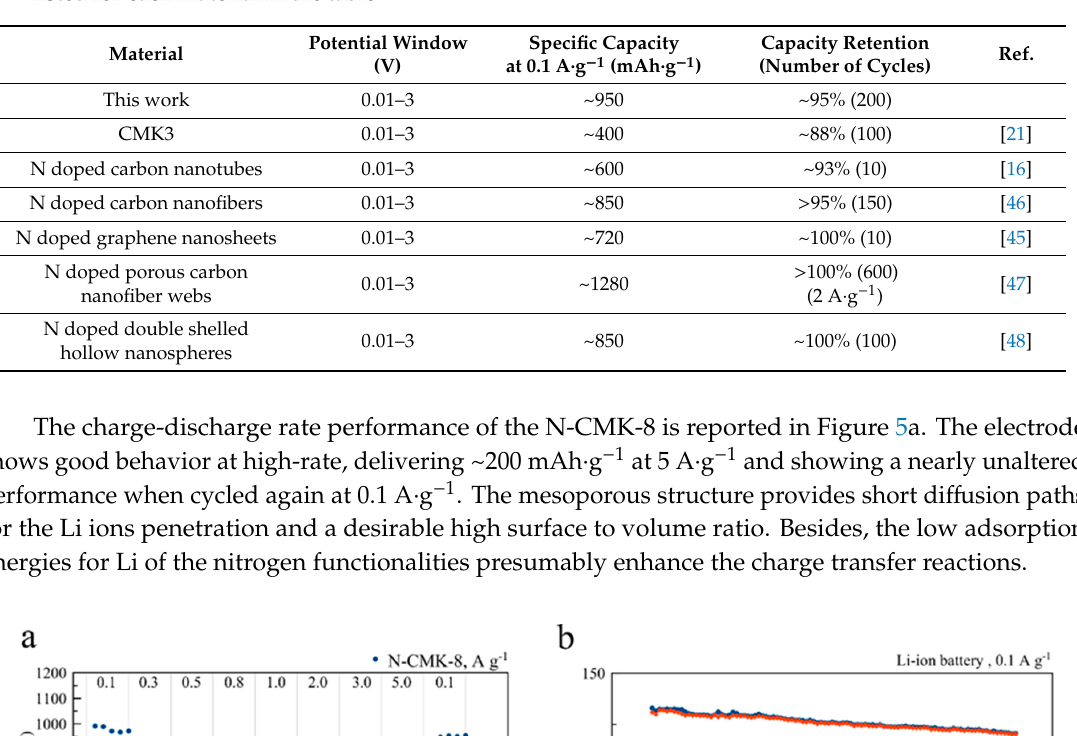
Table 1. CMK-3 and N-doped carbon materials used as anodes in Li-ion batteries are compared with this work (N-CMK-8). Potential windows, specific capacity, capacity retention, and relative reference is listed for each material in the table.